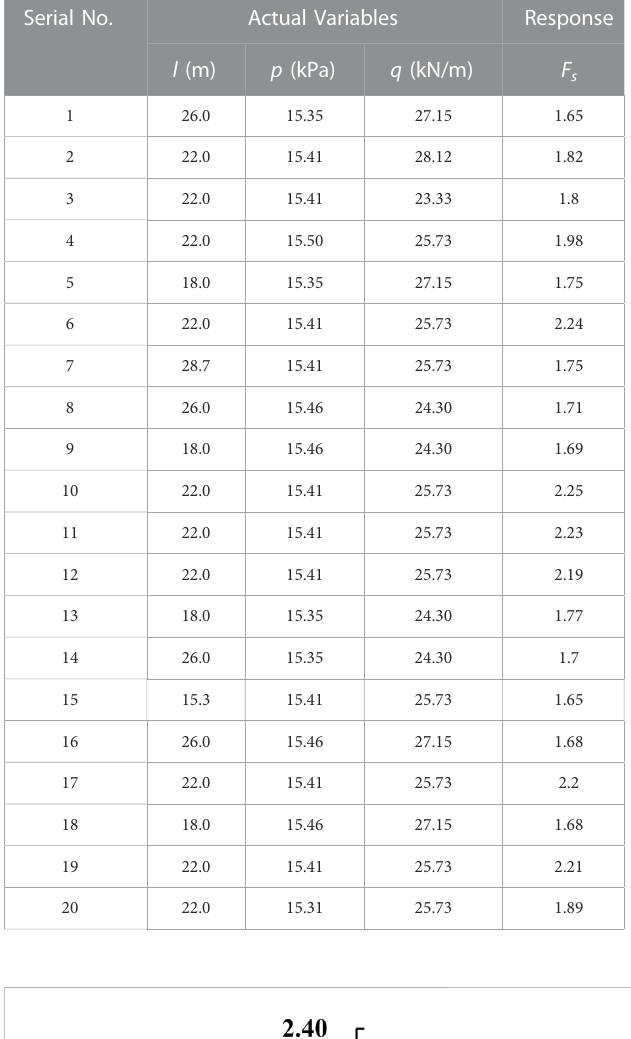
TABLE 4 Experimental design and response of CCD within region U 2 . Serial No.